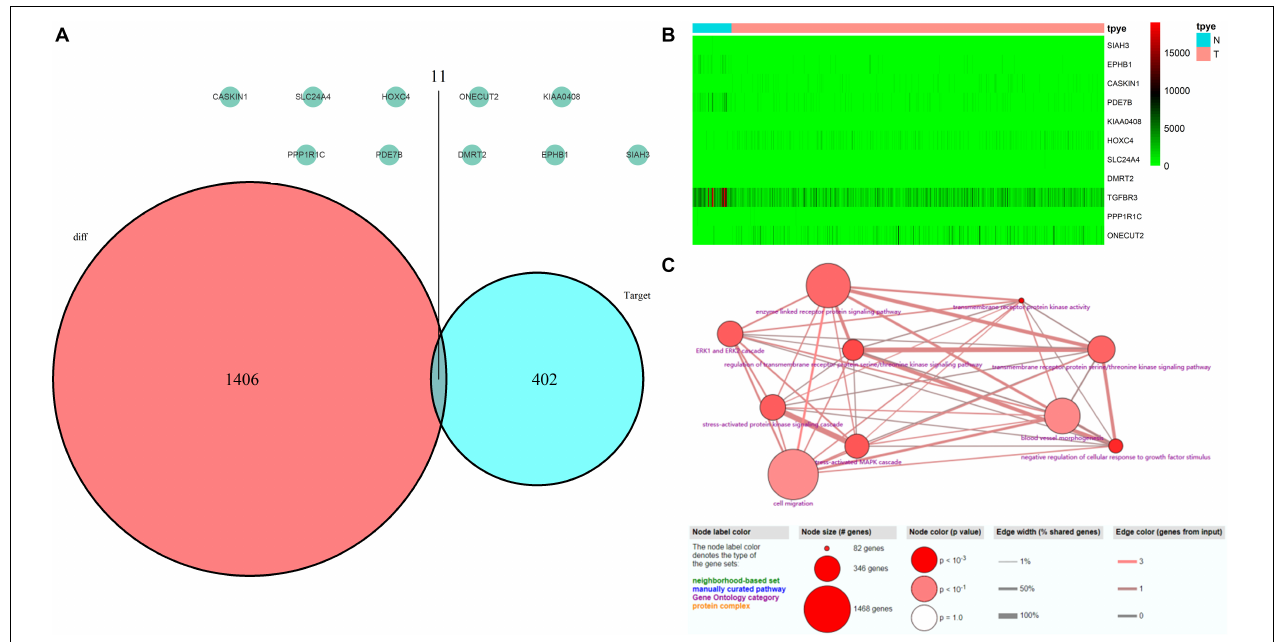
FIGURE 8 | Validation of miRNA-regulated genes by the TCGA database. (A) Interaction between predicted miRNA-regulated genes and differentially expressed genes between PCa and normal adjacent prostatic tissues selected from the TCGA database. (B) Heatmap generated from data of 552 samples downloaded from the TCGA database. (C) GO terms analyses of these 11 genes.